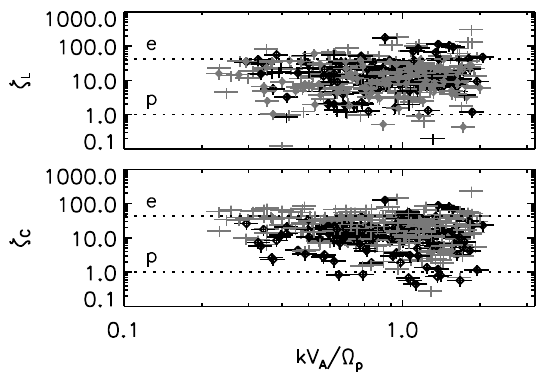
Figure 3. Landau resonance parameter with protons ζ L and cy- clotron resonance parameter with protons ζ C for the data set pre- sented in Fig. 2. The resonance line for protons are marked by “p”, and that for electrons are marked by “e” multiplied by a factor of p m p /m e (cid:39) 42 .